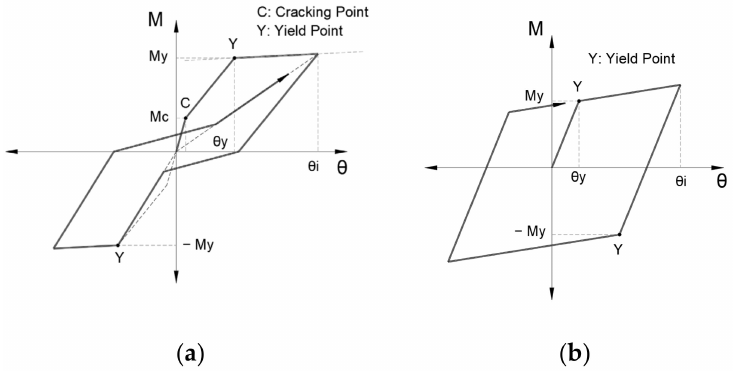
Figure 7. Hysteresis model. ( a ) Degrading trilinear slip model for RC sections; ( b ) bilinear model for steel sections [23].